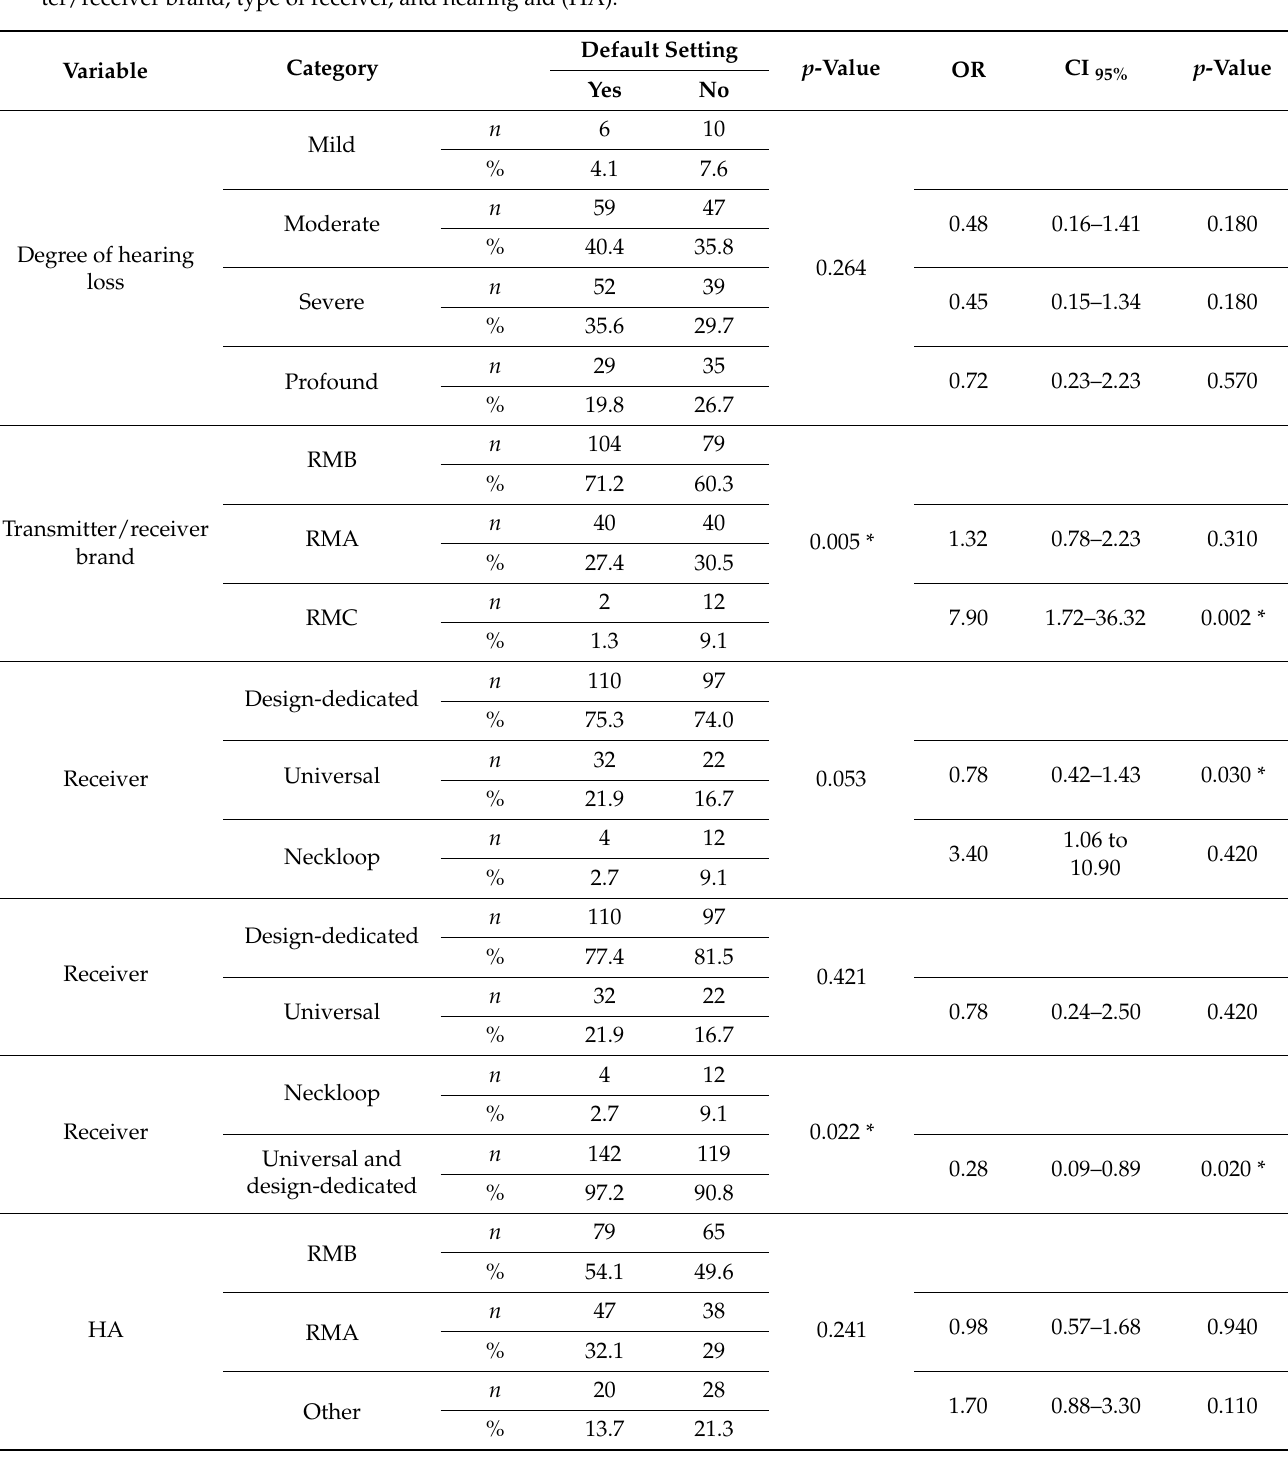
Table 1. Analysis of the association between the default setting variable and the degree of hearing loss (HL), transmit- ter/receiver brand, type of receiver, and hearing aid